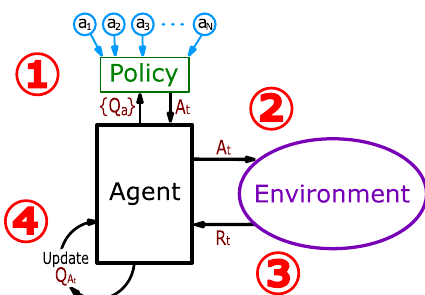
Fig. 3 Reinforcement learning process: (1) At time t the agent chooses an action A t based on a policy and the set of estimates { Q a } , (2) the agent applies action A t onto the environment, (3) the agent obtains reward R t from the environment, and (4) the agent updates the estimate for the action chosen Q A